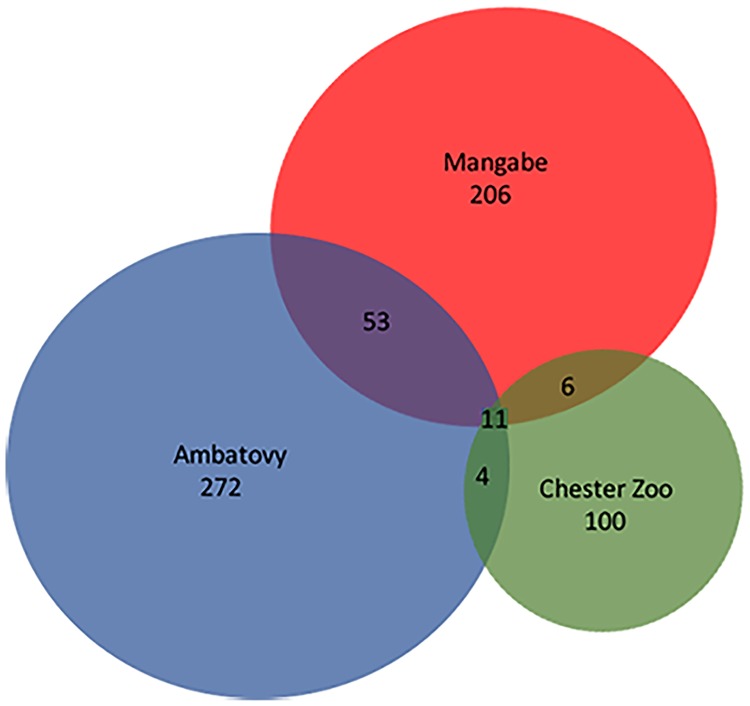
Graphical representation of shared and unique OTUs (Operational Taxonomic Units) of the three sampled populations of golden mantella frogs (Chester Zoo, Ambatovy and Mangabe), where the size of discs and overlaps among discs is proportional to the true number observed.